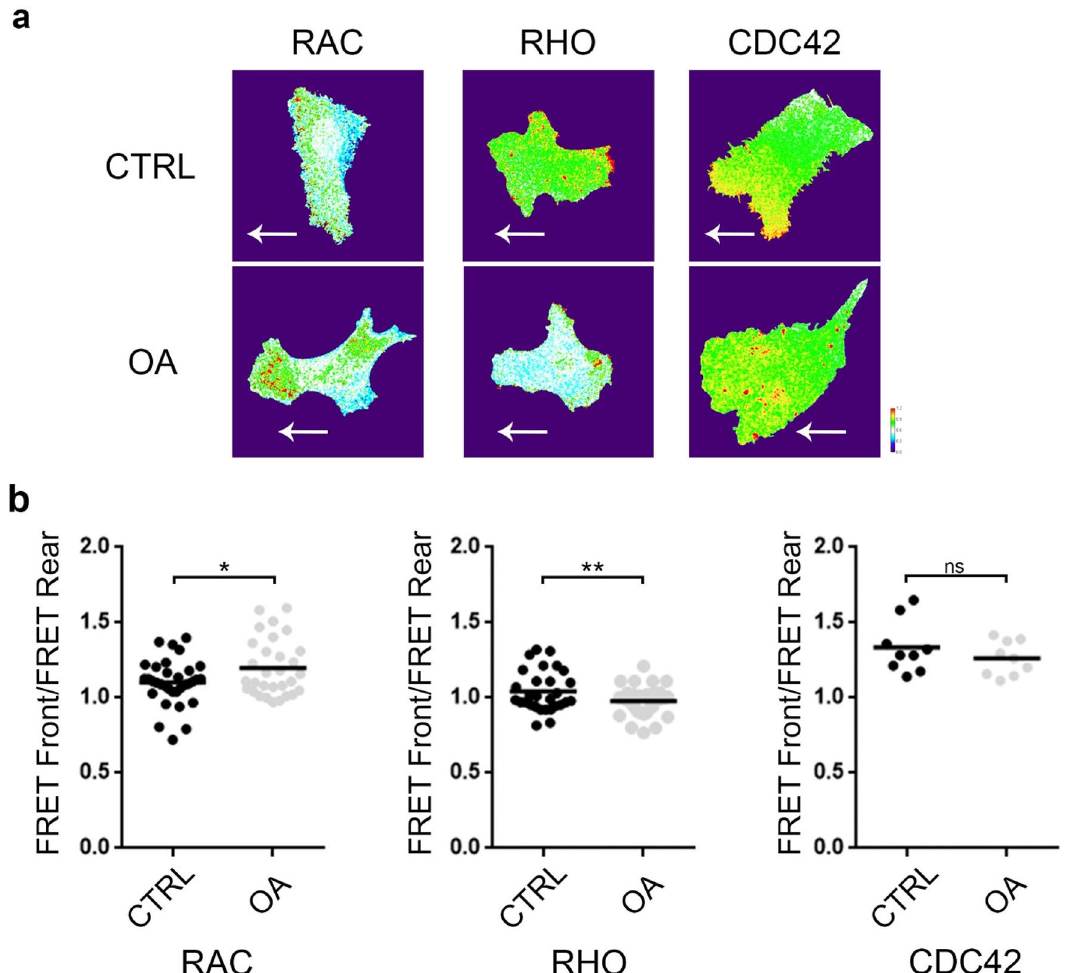
Figure 5. FRET revealed that OA affect the activity of RhoGTPases in migrating cells. ( a ) Confocal images of representative cells showing FRET signals for Rho, Rac and Cdc42 FRET probes in control (top) and OA (bottom). The white arrow indicates the orientation of the cell during migration. Scale bar 20 μm. ( b ) Scatter plot of the Front/Rear ratio of FRET from three independent experiments. The statistical significance was tested using an unpaired t-test. *p < 0.05, **p <